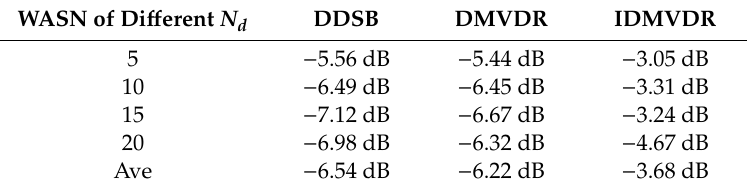
Table 6. The noise reduction performance of di ff erent N d in terms of SegSNR.